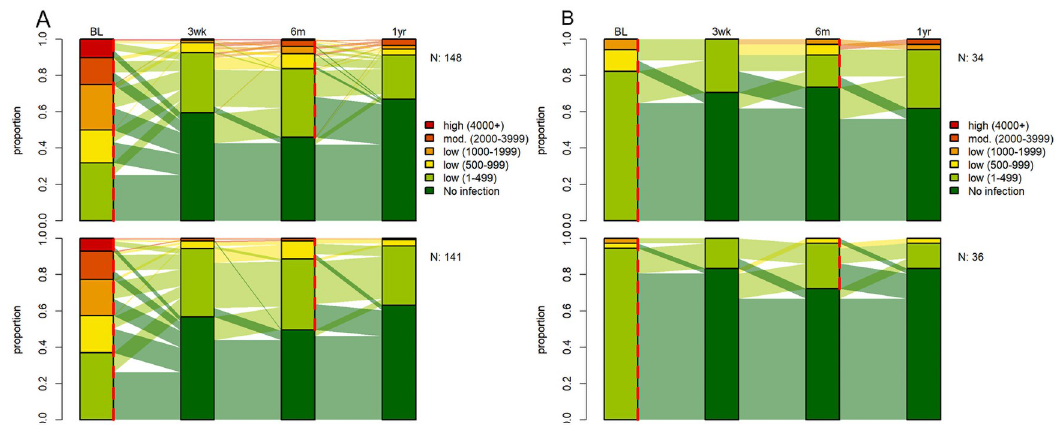
Fig 4. Proportion of infection intensities of hookworm at baseline, 14–21 days, six and 12 months post-treatment in Lao PDR (A) and Pemba Island (B) for ivermectin-albendazole above and albendazole-placebo below. 289 participants in Lao PDR and 40 participants on Pemba Island were initially infected with hookworm and had a complete data set. Red dashed lines at baseline and follow up represent treatment time points. Abbreviations: BL, baseline assessment; N, number of participants with a complete data set; 3wk, 14–21 days post-treatment follow-up; 6m, 6 months post-treatment follow-up; 1yr, 12 months post-treatment